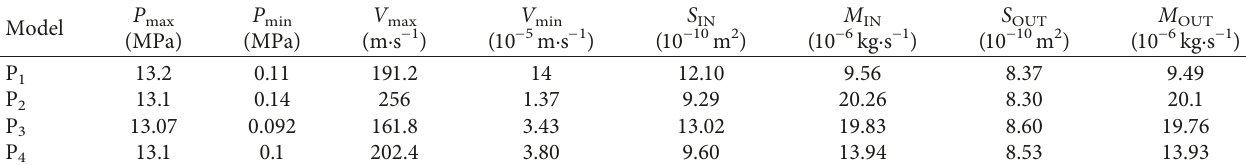
Table 8: Simulated results of seepage parameters in four models under a high inlet pressure of 13.1MPa. Model